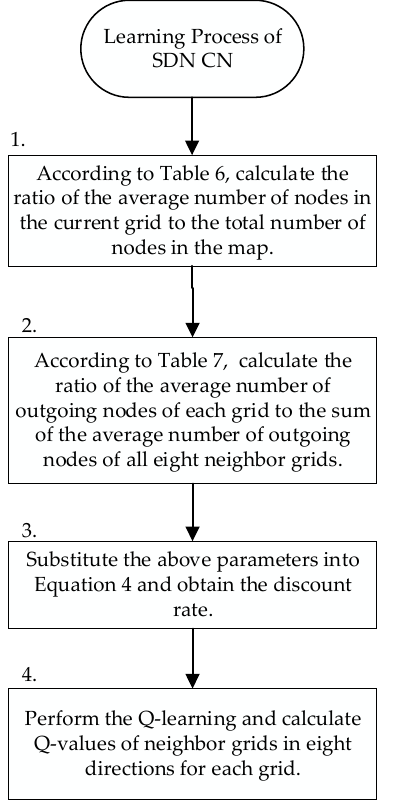
Figure 7. SD-QGrid learning process executed by the SDN CN.